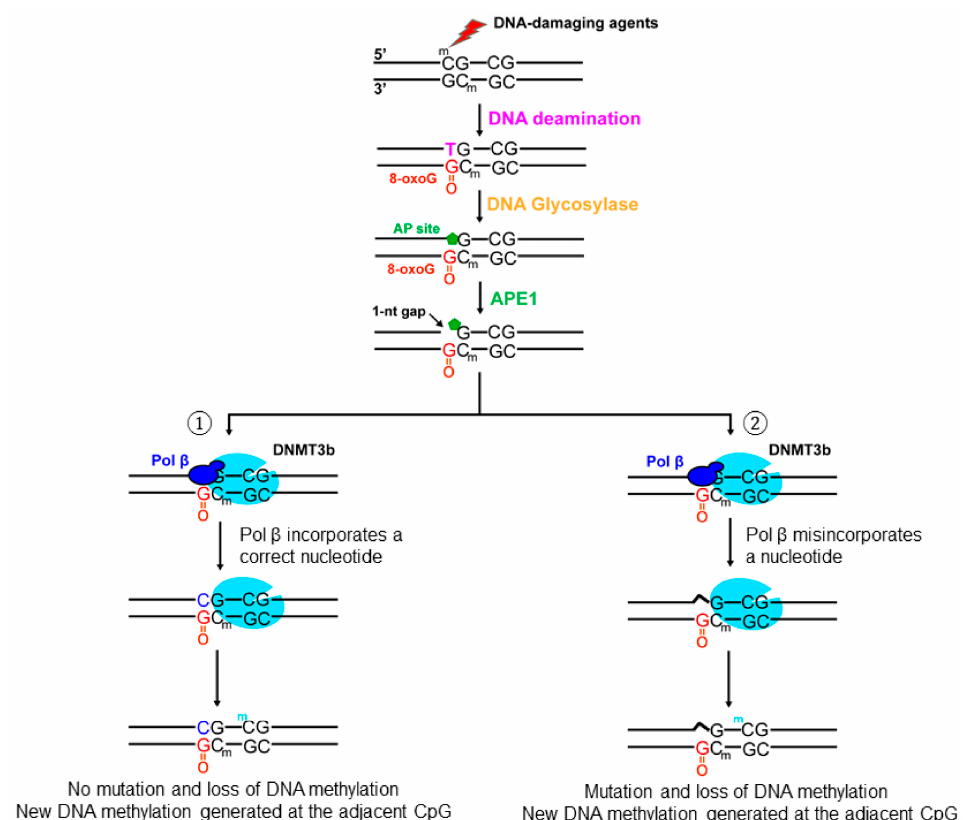
Figure 7. Oxidative DNA damage alters DNA methylation patterns in the promoter and transcribed regions of the BRCA1 gene through the crosstalk between pol β and DNMT3b. Oxidized DNA base lesions such as 8-oxoGs can occur at the CpGs located in the promoter and transcribed regions of the BRCA1 gene. The lesions can be removed by a DNA glycosylase, leaving an abasic (AP) site. The AP site is subsequently cleaved by APE1, generating the 1-nt gap intermediates. Subsequently, pol β is recruited and performs nucleotide insertion. In the scenario where pol β inserted a correct nucleotide to bypass an 8-oxoG, DNMT3b is recruited to the CpG dinucleotides through its interaction with pol β . This allows DNMT3b to create a new 5mC on the adjacent CpG site but not at the damaged site because of the inhibition of the methyltransferase activity by the base lesion. This then results in the loss of 5mC and a new methylation site (subpathway 1). In the scenario where pol β inserted an incorrect nucleotide to bypass an 8-oxoG, DNMT3b is also recruited to the damage site through its interaction with pol β leading to a mutation, loss of 5mC, and addition of a new 5mC at the adjacent CpG site (subpathway 2).